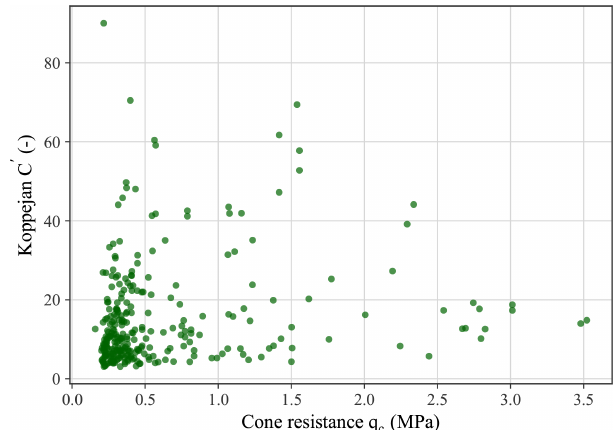
Figure 2. Plot of the Koppejan C (cid:48) values against the corresponding cone resistance q c , indicating the lack of a distinct visual relation-